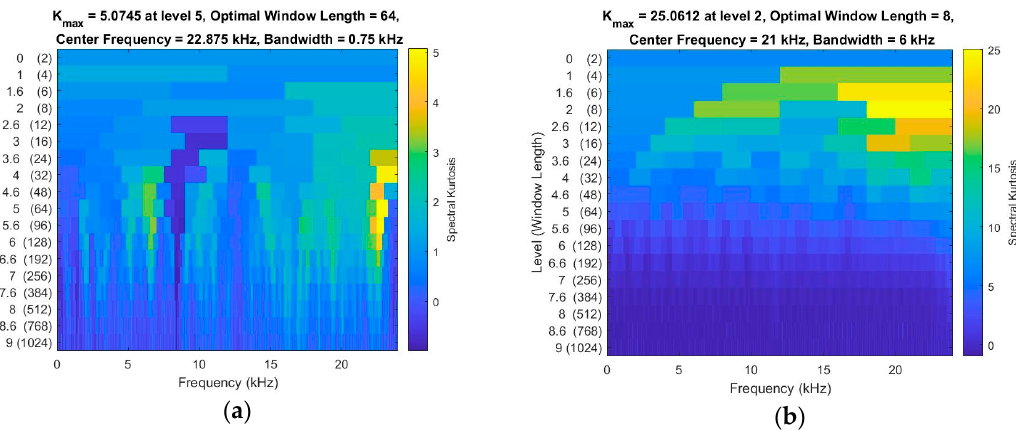
Figure 8. Kurtograms: ( a ) vibration signal at 0.021 in and 3 hp and ( b ) pressure signal at 0.021 in and P u /2.